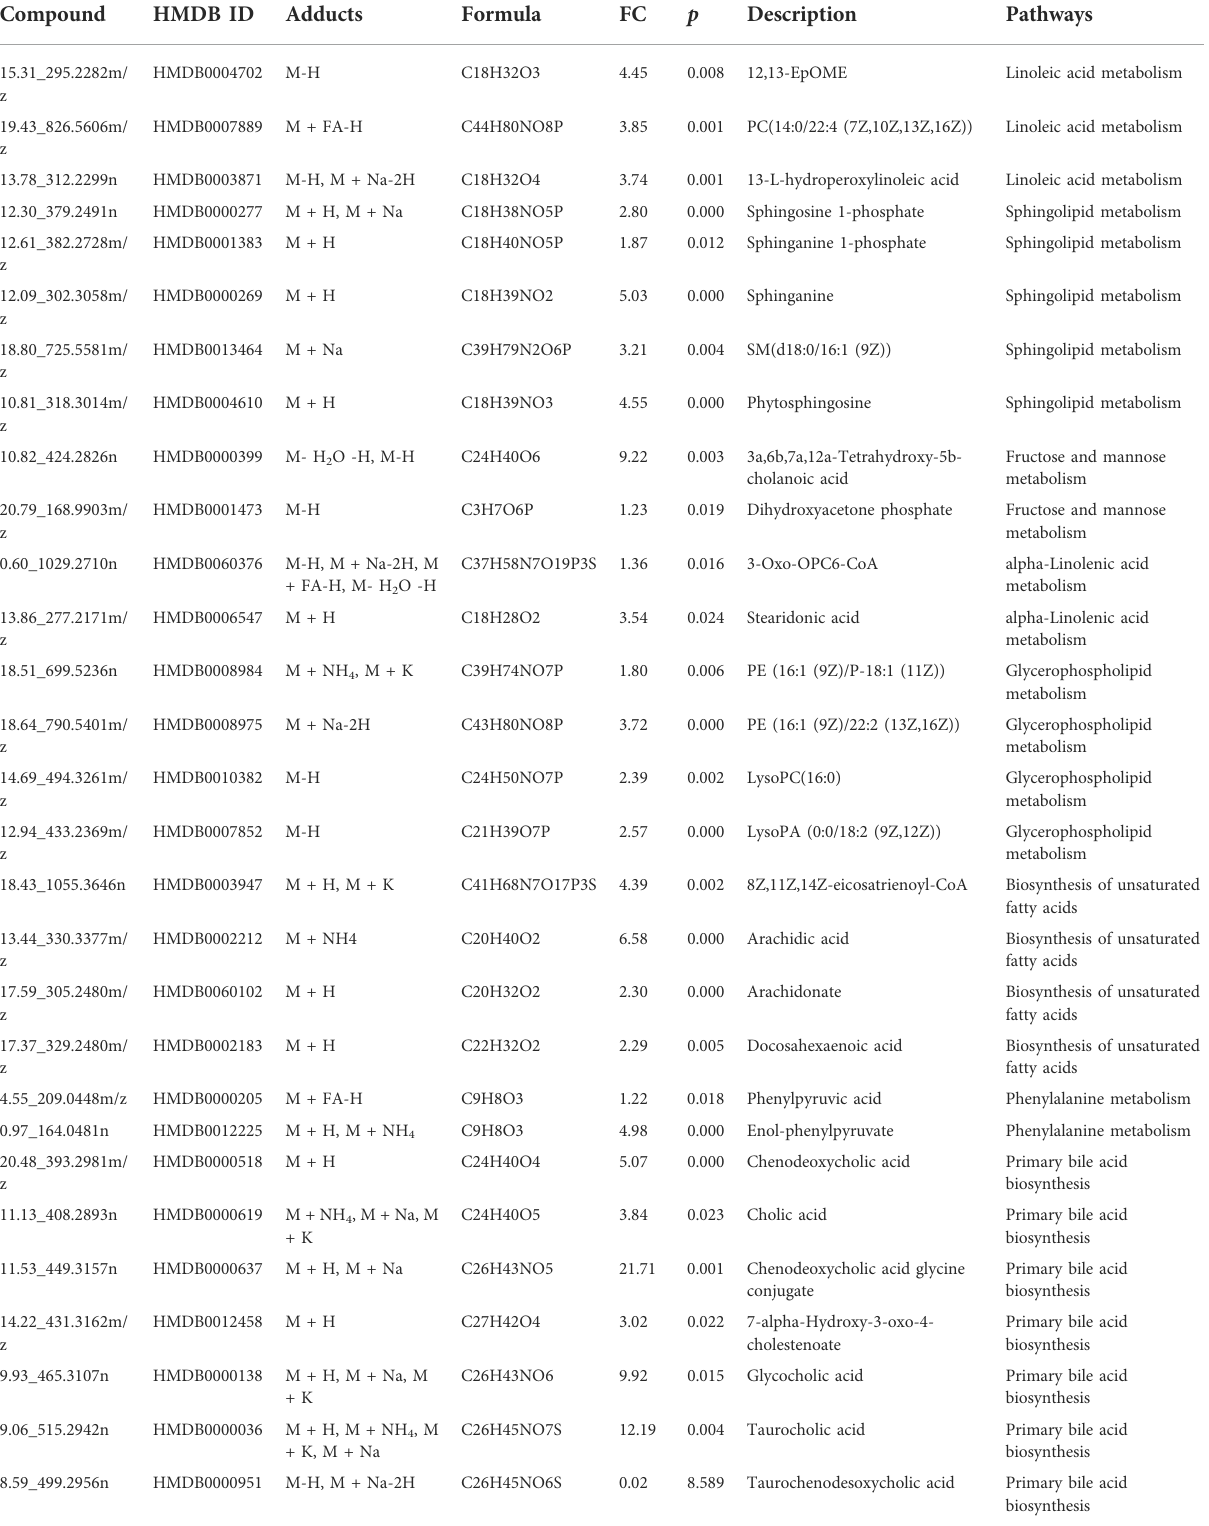
TABLE 3 Potential biomarkers found in the